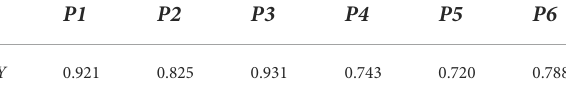
TABLE 3 Gray correlation value between the ingredients and the comprehensive evaluation value of ef fi